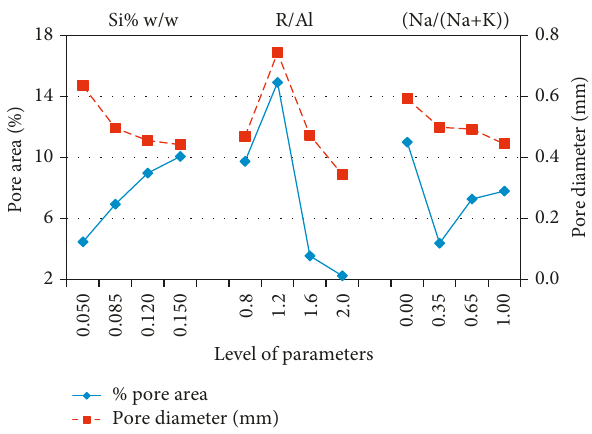
Figure 7: Effect of the studied parameters on the porosity of the Si foams.